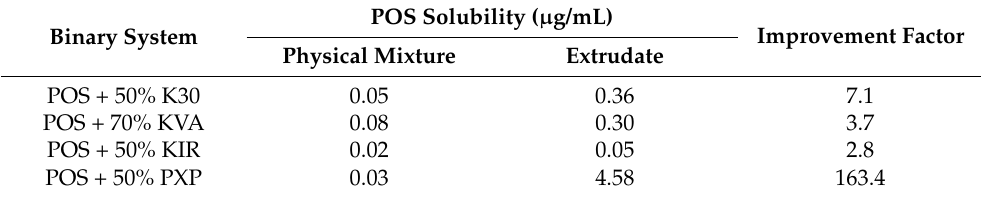
Table 2. The measured aqueous solubility values obtained for the physical mixtures and extrudates. Binary